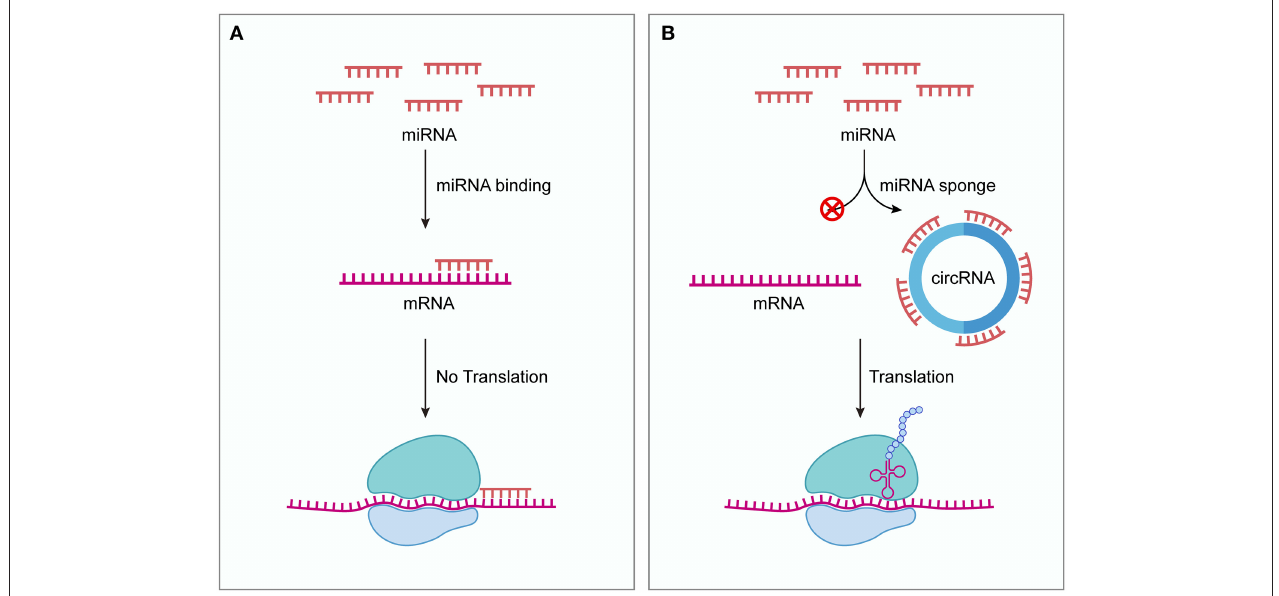
FIGURE 1 | circRNAs function as ceRNAs. (A) Without competing transcripts circRNAs, miRNAs bind to target mRNAs through sequence complementarity, blocking the translation of target mRNAs. (B) circRNAs can competitively sequestrate miRNAs and derepress their target mRNAs, thus promoting the expression of target genes. ceRNA, competing endogenous RNA; circRNA, circular